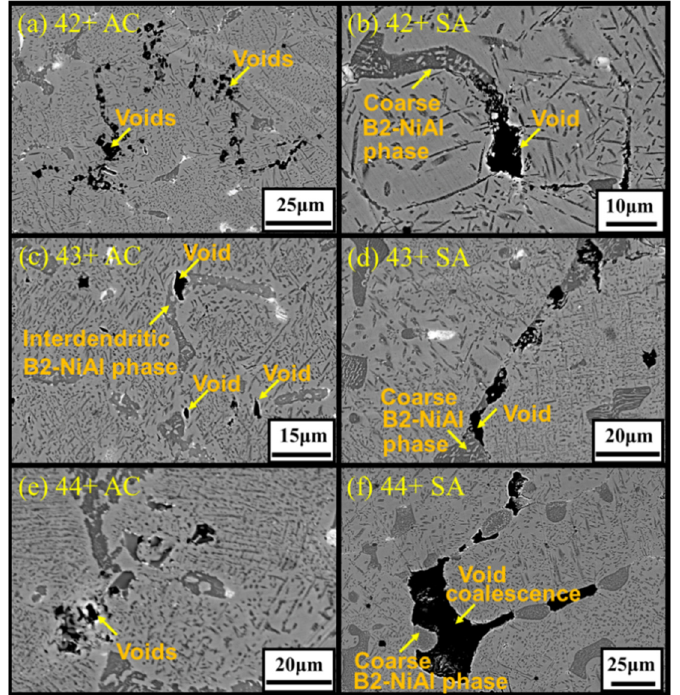
Figure 14. SEM-BSE images showing the microstructure around the fracture region for alloys ( a ) 42+ AC, ( b ) 42+ SA, ( c ) 43+ AC, ( d ) 43+ SA, ( e ) 44+ AC, and ( f ) 44+ SA after the creep test in air at 750 °C and 150 MPa.